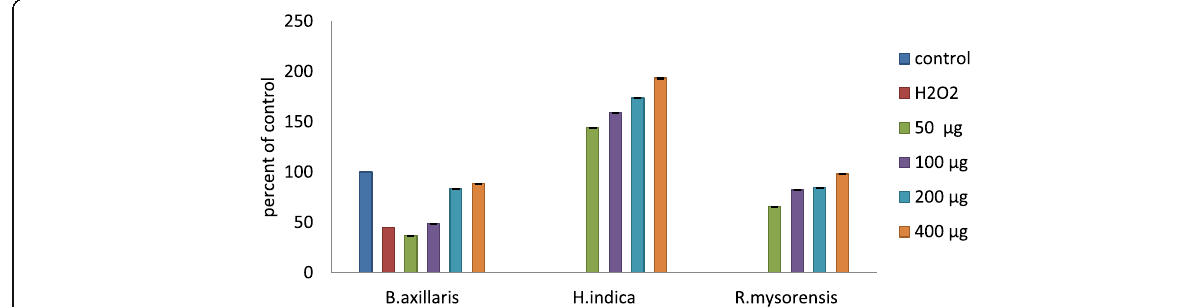
Fig. 4 Neuroprotective activity of chloroform fractions from methanolic extracts of B.axillaris, H.indicus and R.mysorensis on SK N SH cells (human neuroblastoma cell line) against H 2 O 2 induced cell death in SK N SH cells in MTT